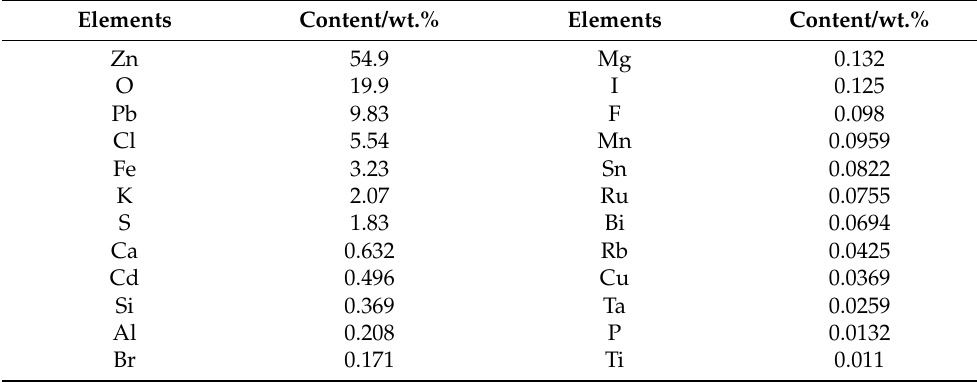
Figure 1. XRD pattern of zinc hypoxide. Table 1. Sample element composition analysis.